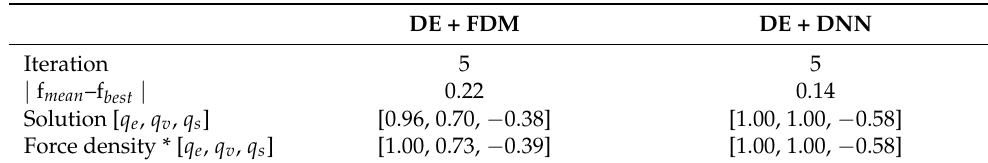
Table 5. The final results of the 3D-truncated tetrahedron tensegrity using an FDM and a DNN-based form-finding model with a DE algorithm.